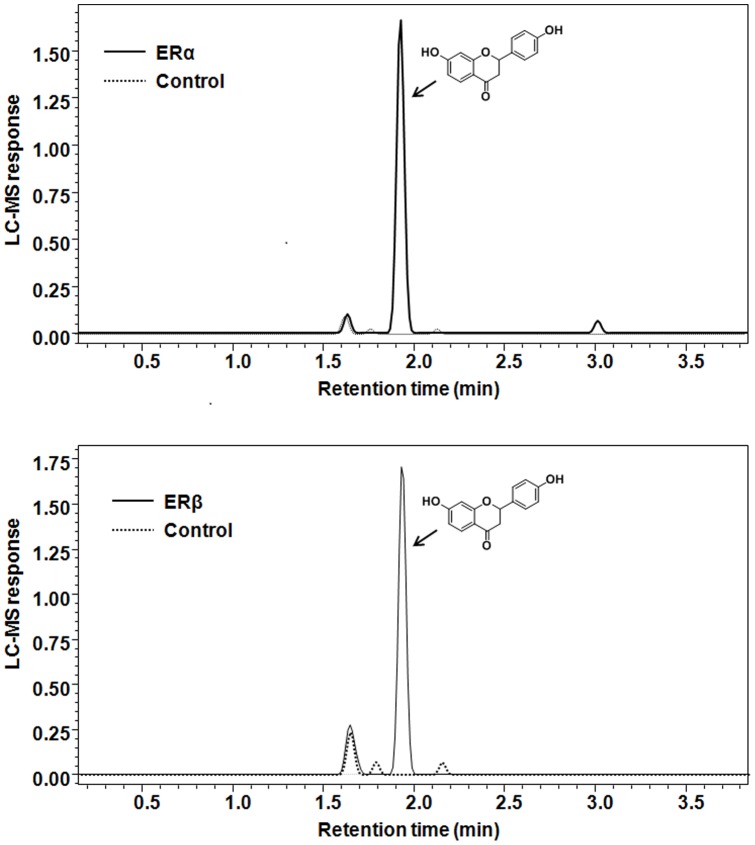
Liquiritigenin from licorice crude extract is the major ligand for ER subtypes in the pulsed ultrafiltration LC-MS analysis.Positive ion electrospray LC-MS chromatograms showing the ultrafiltration mass spectrometric screening of crude extract of Glycyrrhiza uralensis; GU to A) ERα and B) ERβ. Denatured ER was used as a control for non-specific binding and specific binding is indicated by increases in the chromatographic peak areas.